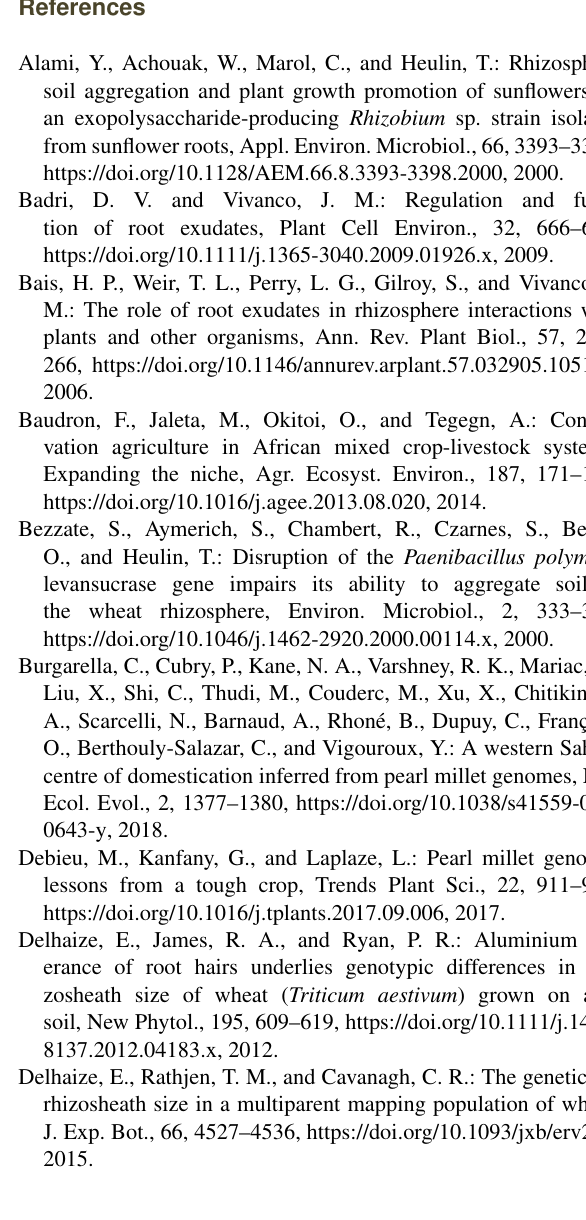
Table A1. RAS / RT means (rhizosheath size) of the four pearl millet lines measured in Ndour et al. (2021), root (RT) mass, shoot mass, total plant biomass measured for the four pearl millet lines, and the mean values of the root-adhering soil (RAS) mass calculated for the four pearl millet lines. All these parameters are measured/calculated at 28d of plant growth. Lines RAS / RT RT (g) Shoot (g) Plant biomass (g) RAS (g) L220 8.4 0.116 ( ± 0.07) 0.286 ( ± 0.08) 0.402 ( ± 0.15) 0.972 ( ± 0.6) L3 14.9 0.096 ( ± 0.06) 0.194 ( ± 0.07) 0.290 ( ± 0.13) 1.433 ( ± 0.9) L132 23.3 0.082 ( ± 0.04) 0.231 ( ± 0.03) 0.313 ( ± 0.06) 1.921 ( ± 0.8) L253 20.8 0.128 ( ± 0.06) 0.244 ( ± 0.07) 0.372 ( ± 0.13) 2.659 ( ±